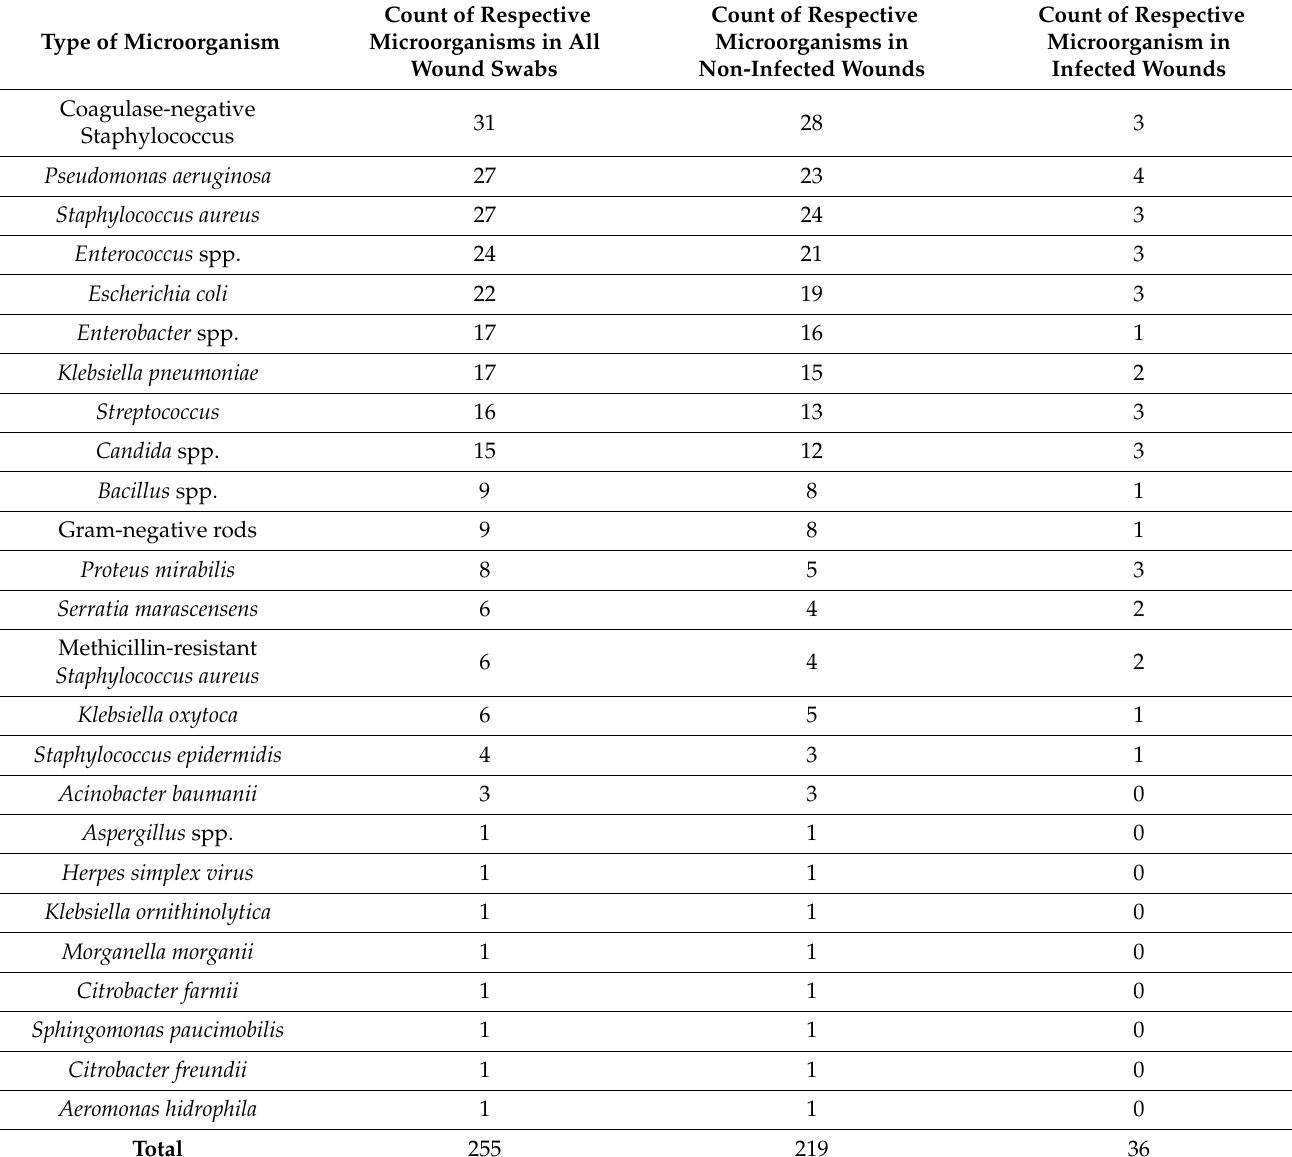
Table 2. The presented table gives an overview of the total count of microorganisms found in positive wound swabs, as well as the respective count of each microorganism in non-infected and infected wounds. Count of Respective Count of Respective Count of Respective Type of Microorganism Microorganisms in All Microorganisms in Microorganism in Wound Swabs Non-Infected Wounds Infected